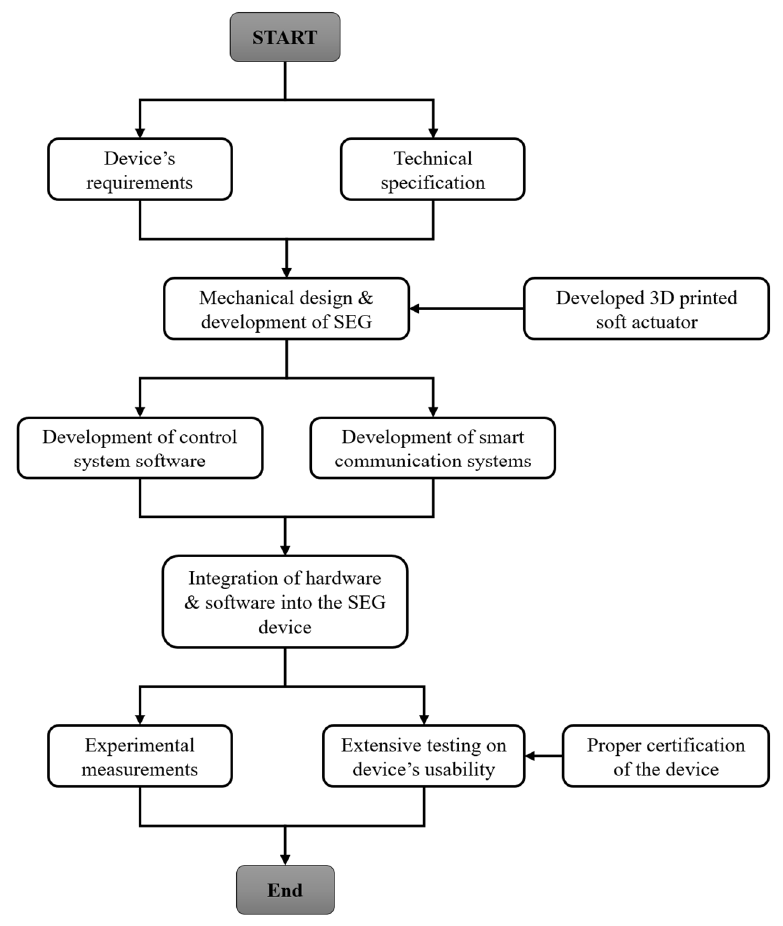
Figure 1. Flowchart of the soft robotic exoskeleton’s development.